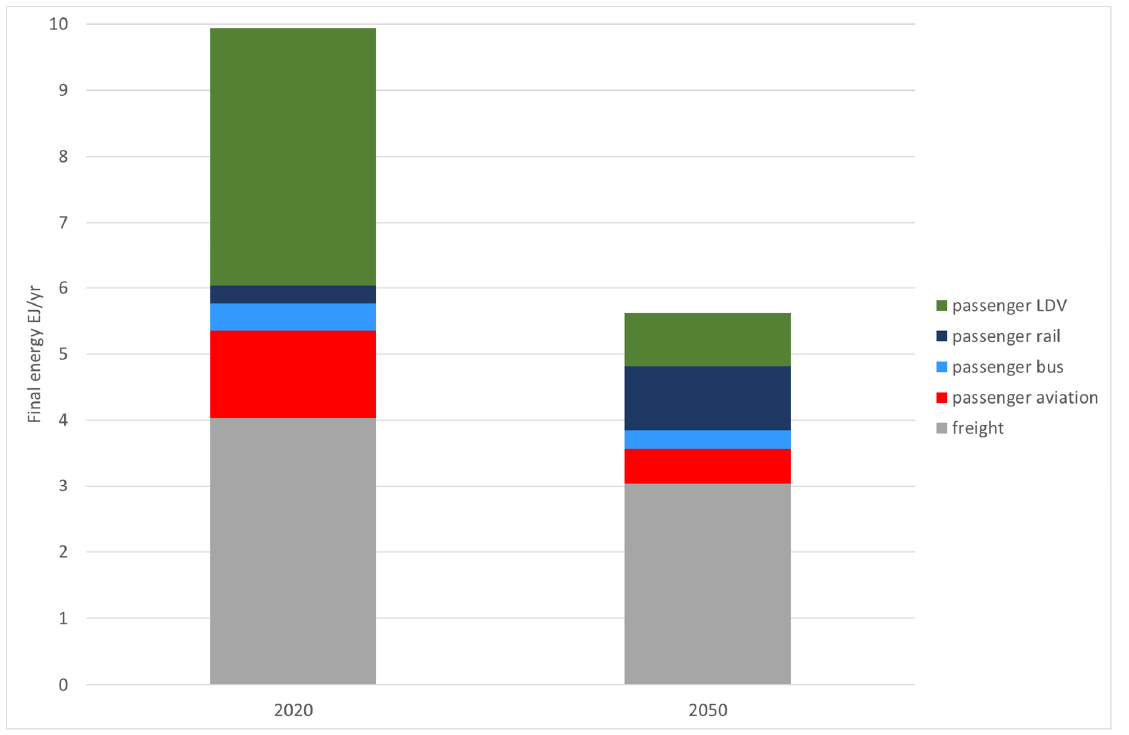
Figure 2. Transport disaggregation. This figure shows the division of final energy for transport in the IMAGE ‘1.5C Total’ scenario for the Western Europe (WEU) region in 2020 and 2050 [16]. LDV = Light Duty Vehicle (predominantly cars). Although in this case data are directly reported by IM- AGE, in models with less granular resolution, the disaggregation step would estimate the passenger mobility proportions of total final energy for transport.